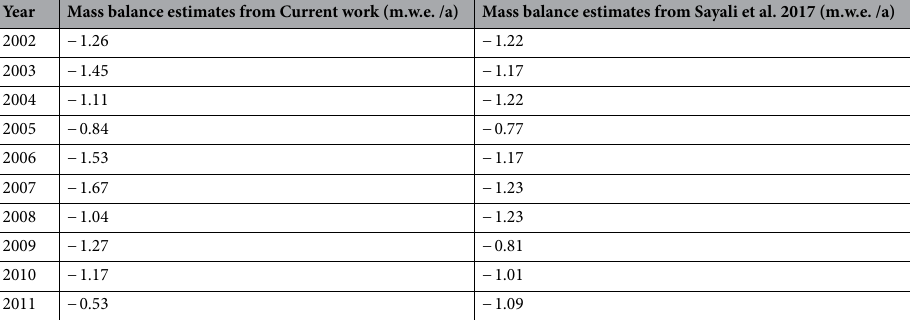
Table 1. Comparison between the glacier mass balance estimates obtained in this study and that obtained by Sayali et al., 2017.